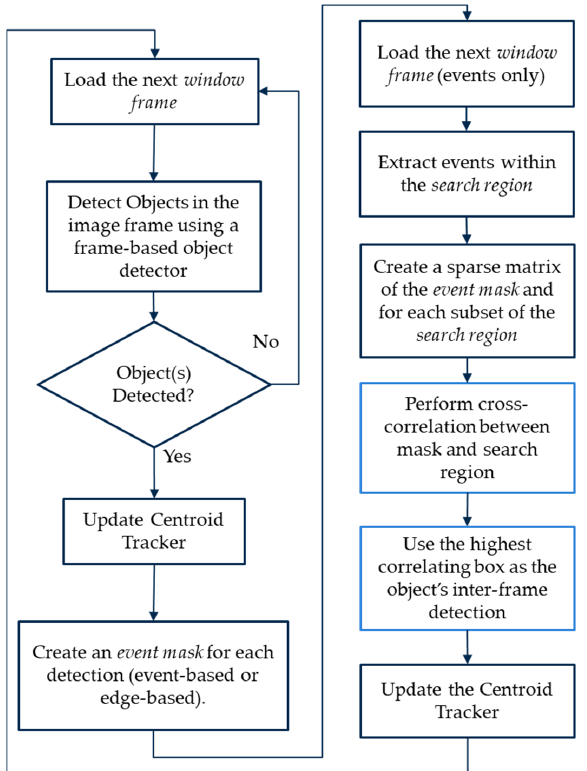
Figure 9. Summary flowchart of the overall hybrid object detection and tracking process. The branch on the right would repeat for every consecutive window frame that only contains events given prior frame-based object detections until a new image is read. The window frame size is set before this process